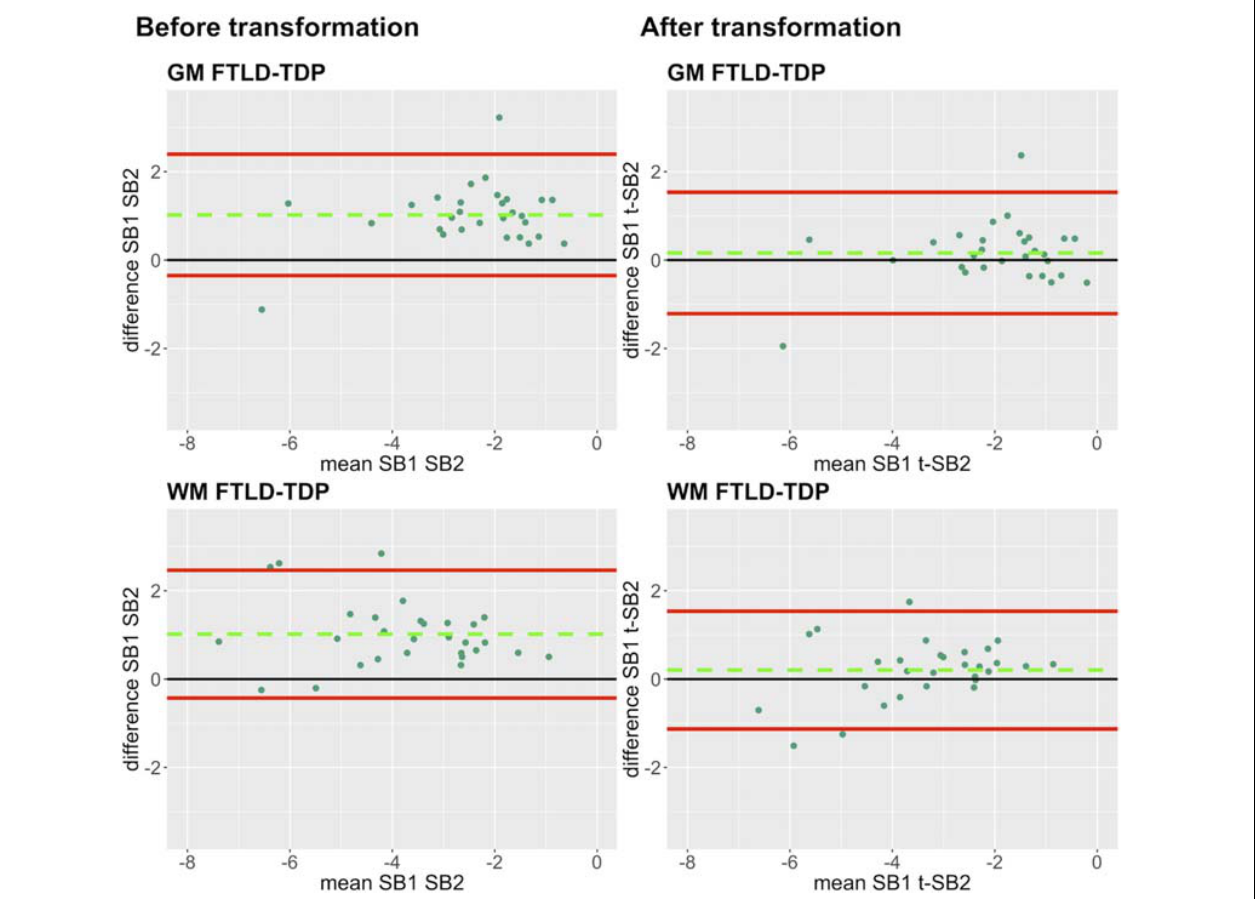
FIGURE 6 | Bland-Altman plots of test-retest agreement between duplicate measurements of pathology before vs. after transformation in FTLD-TDP. Plots portray test-retest agreement between duplicate measurements of digital pathology (i.e., ln %AO) in FTLD-TDP from SB1 and SB2 before and after transforming the data using our validated linear regression-based method. Here we illustrate the reduction in batch-related difference in digital measurements resulting from the application of our transformation method in a single train-test split in FTLD-TDP (Step 3). The green dashed line indicates the mean difference between SB1 and SB2 measurements, while the red solid lines mark the 95% limits of agreement between the two measurements. We find that mean difference between SB1 and SB2/t-SB2 is significantly different from zero before transformation ( p < 0.05, one-sample t -test), whereas it is not significantly different from zero after transformation ( p > 0.05) in both GM and WM. FTLD-TDP, frontotemporal lobar degeneration with inclusions of the transactive response DNA-binding protein 43; GM, gray matter; SB1, staining batch 1 (original); SB2, staining batch 2 (new); t-SB2, transformed staining batch 2 (new); WM, white